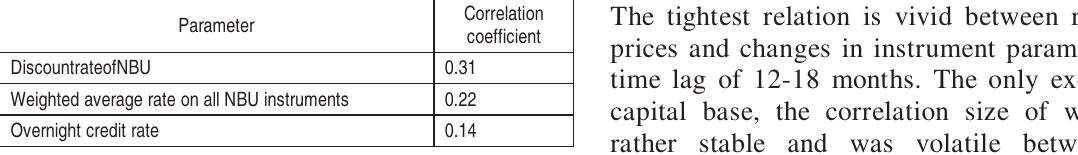
Table 8. Lag analysis of Ukrainian real estate market reactions to the changes of MP instruments (monthly data*) Lag size in